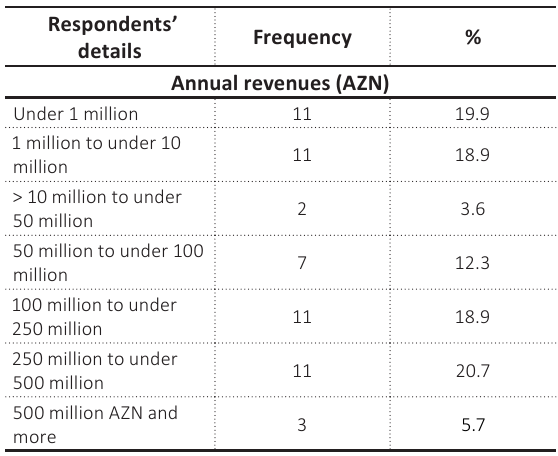
Table 1 (cont). Sample characteristics